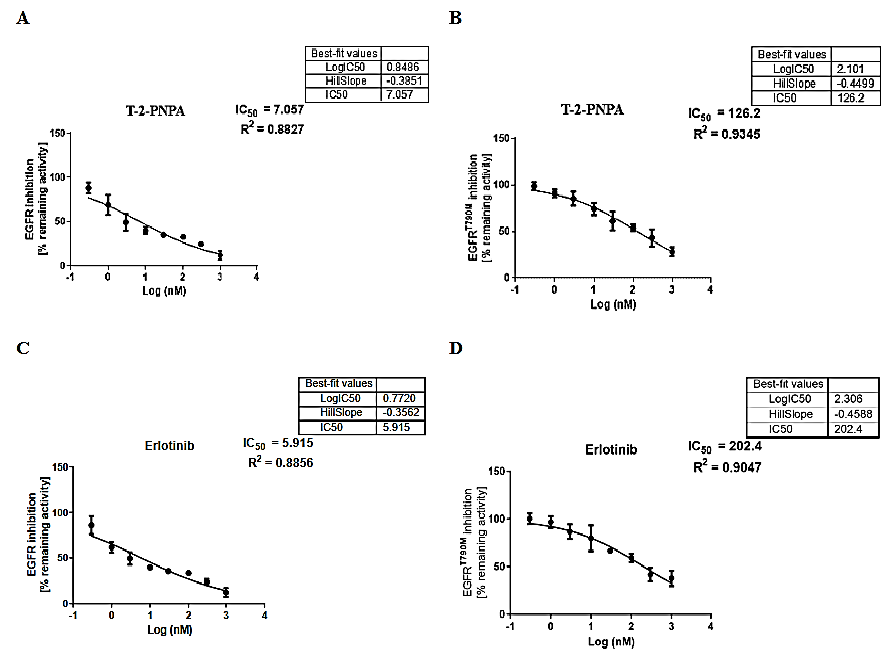
Figure 16. In vitro inhibition of T-2-PNPA against EGFR WT ( A ) and EGFR T790M ( B ) compared with erlotinib’s activities against EGFR WT ( C ) and EGFR T790M ( D ).